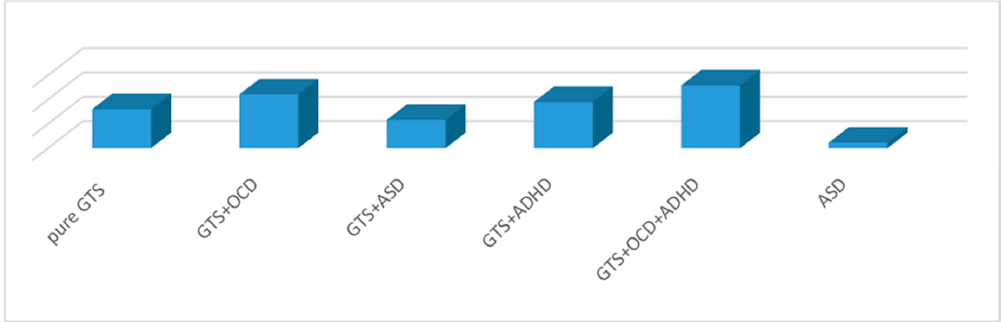
Figure 1. YGTSS score between clinical groups. GTS: Gilles de la Tourette Syndrome; ASD: Autism Spectrum Disorder; OCD: Obsessive–Compulsive Disorder; ADHD: Attention Deficit Hyperactivity Disorder; YGTSS: Yale Global Tic Severity Scale.